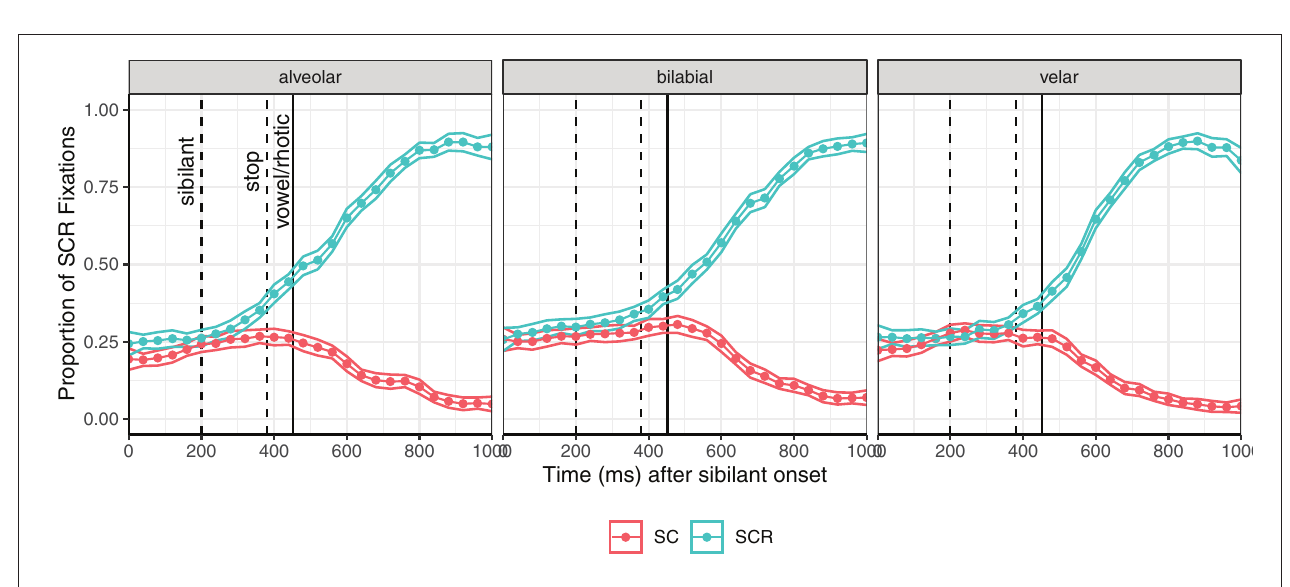
FIGURE 3 | Fixation proportion for /sCr/ clusters (y-axis) by time following the sibilant onset (x-axis, binned into 40 ms windows), cluster type (color: /sC/ = red circles, /sCr/ = teal triangles), and retraction condition (columns). The vertical lines represent a 200 ms delay from the onset of the sibilant, stop, and vowel/rhotic. A fixation executed during the sibilant interval would be observed between the black dashed vertical lines.